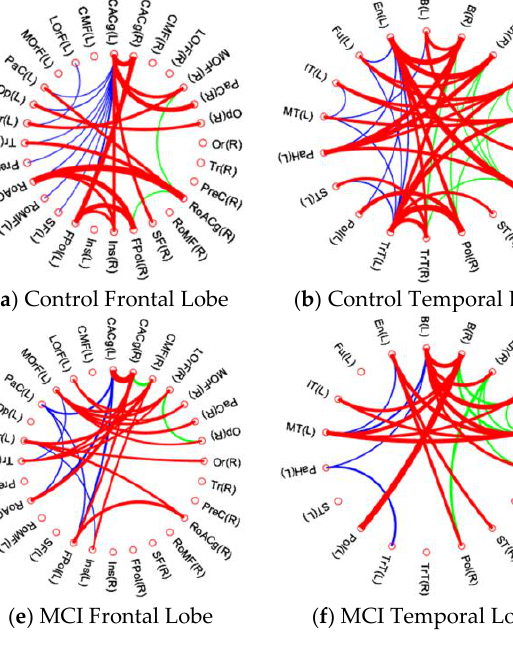
Figure 4. Intra-modular connectivity of each lobe in the control group and MCI group. Control group: ( a ) frontal lobe; ( b ) temporal lobe; ( c ) parietal lobe; ( d ) occipital lobe. MCI group: ( e ) frontal lobe; ( f ) temporal lobe; ( g ) parietal lobe; ( h ) occipital lobe. In each figure, the blue lines depict the lateral links within the left cerebral hemisphere, while the green lines depict the lateral links within the right cerebral hemisphere. The red lines depict the bilateral links between left and right hemispheres. In each figure, the wider line implies a stronger connecting strength, and the thinner line implies a lower connecting strength. Table 6. The number of links between nodes in the lateral lobe and between the bilateral lobes of the control and MCI groups.